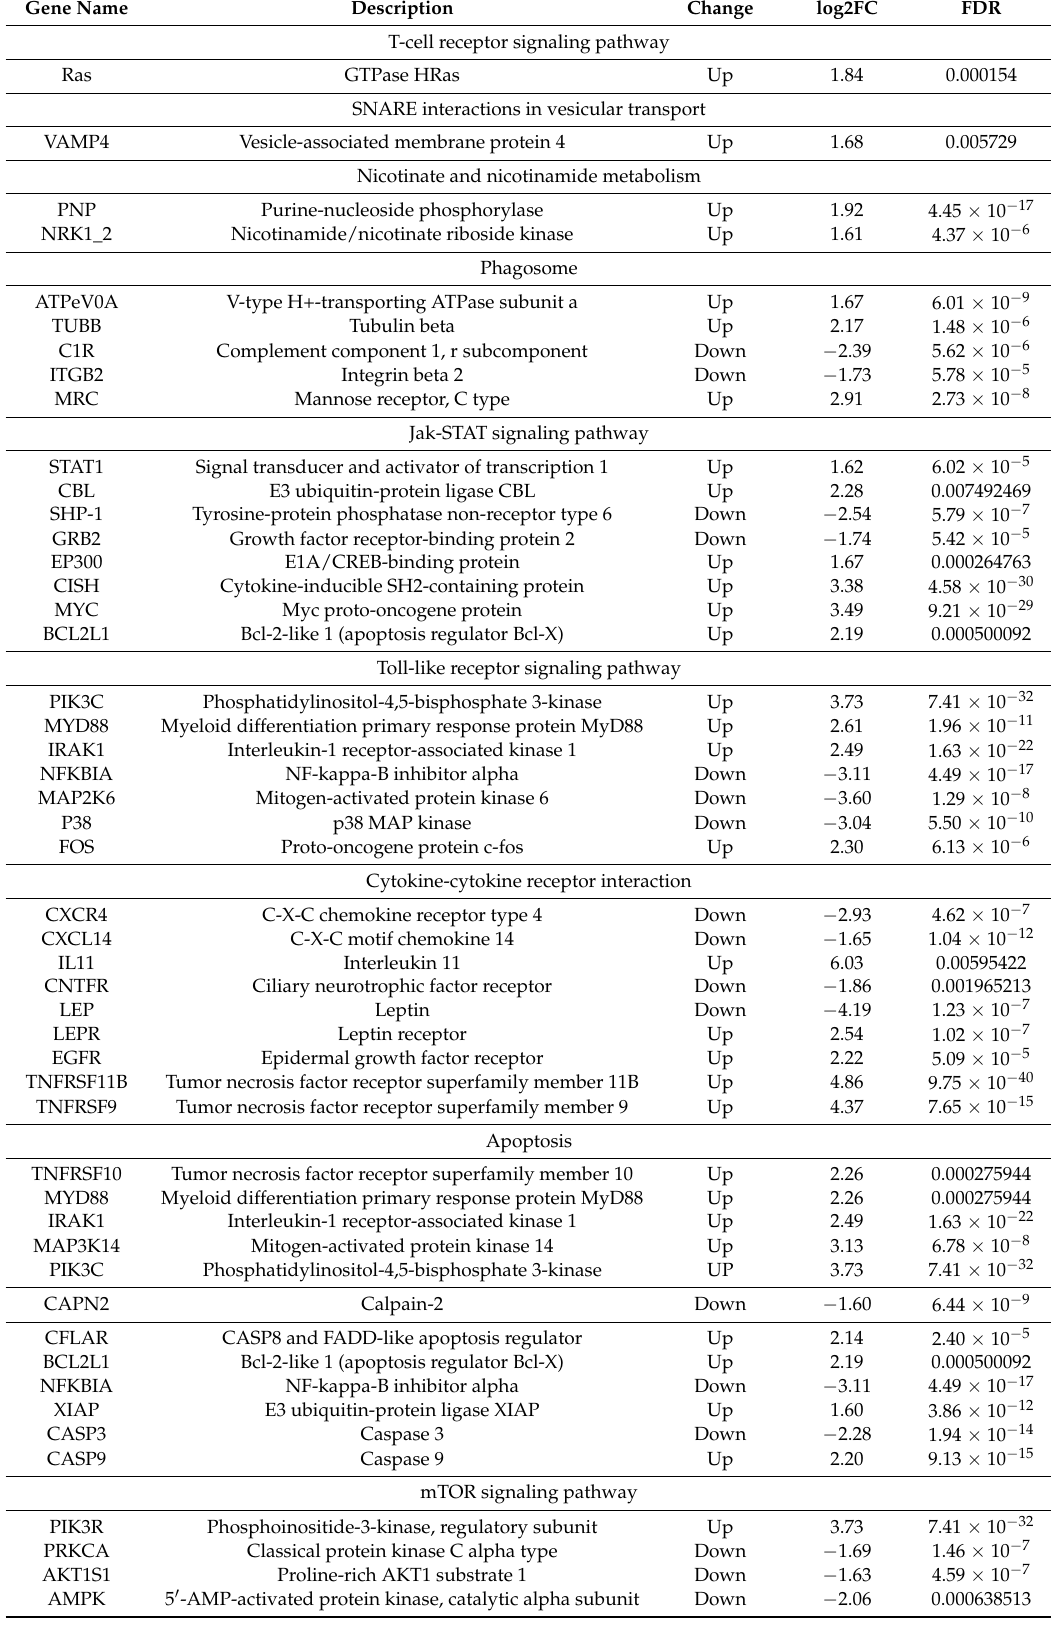
Table 7. Representative immune-related genes that are differentially expressed after reovirus